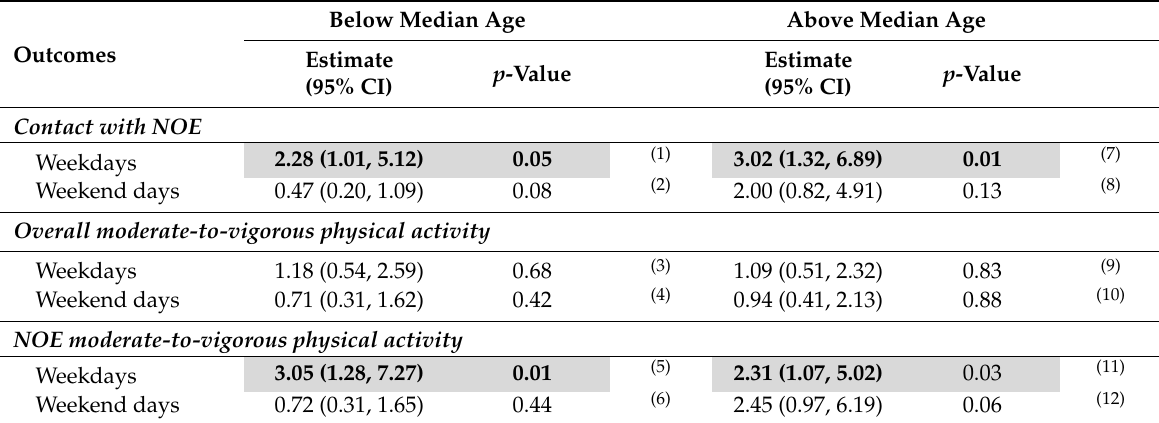
Table 3. Adjusted models for residential NOE availability at 300 m network buffer, stratified by